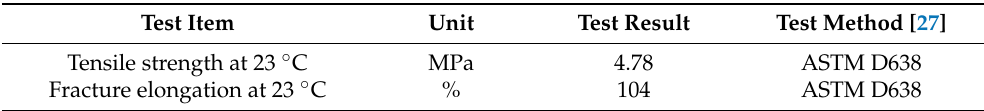
Table 4. Performance parameters of the epoxy resin.